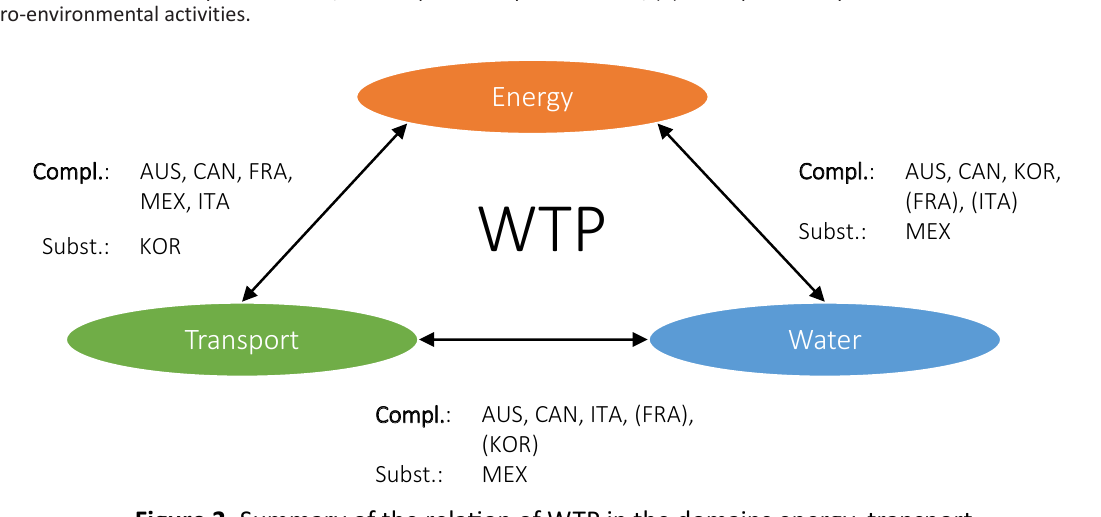
Figure 2. Summary of the relation of WTP in the domains energy, transport and water in six countries. In bold is the dominating relation